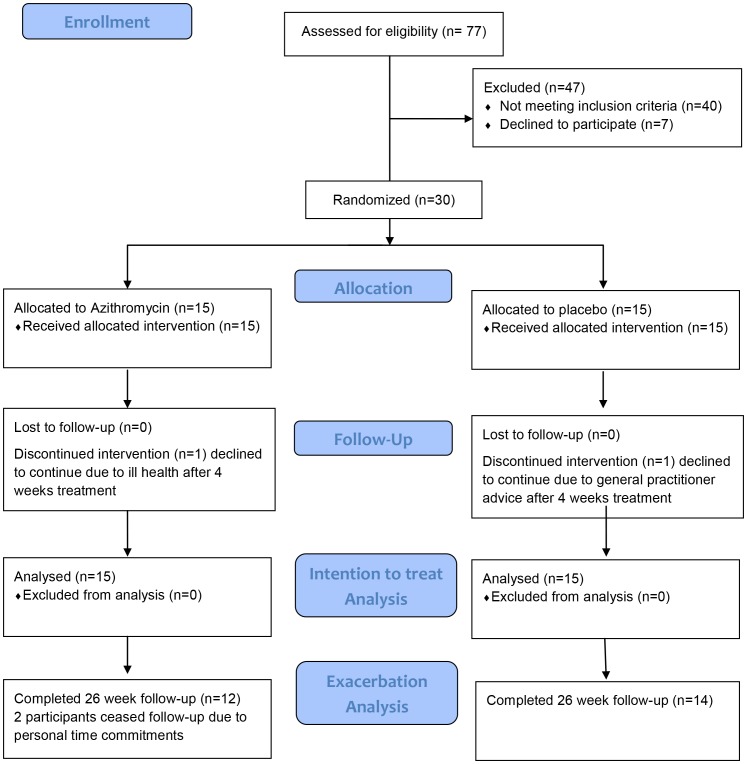
Participant consort diagram.